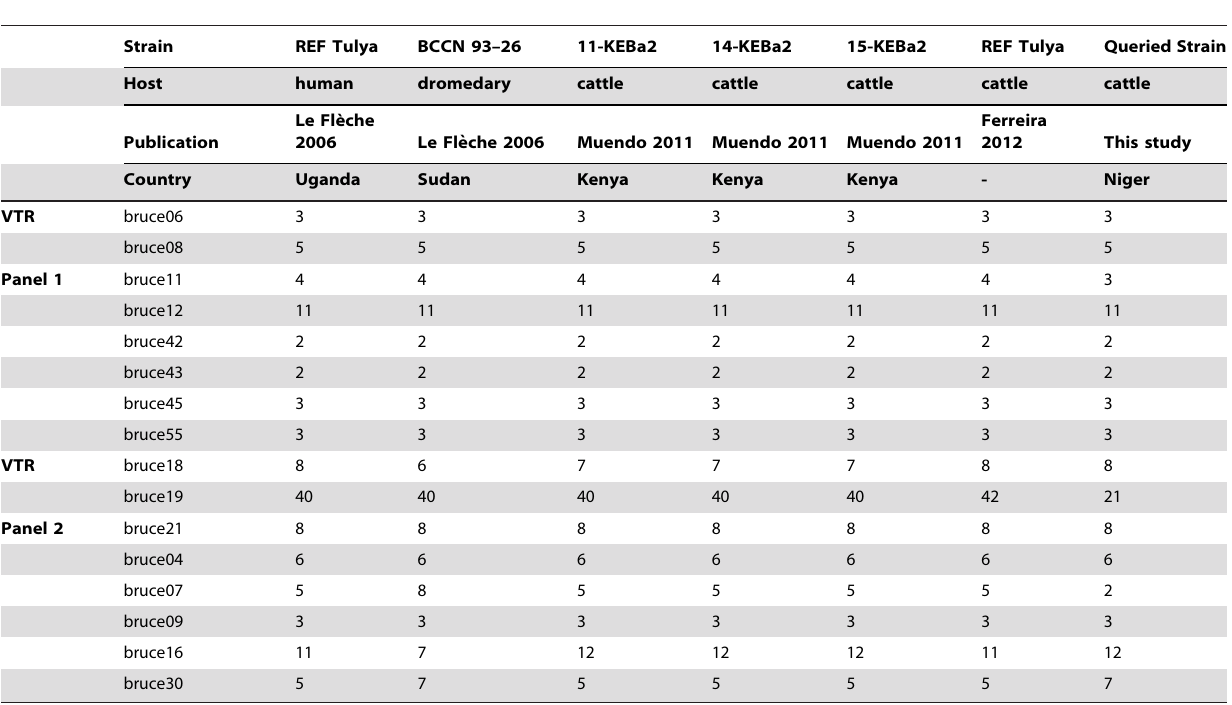
Table 8. The Multiple Loci Variable Number Tandem Repeats analysis (MLVA) profiles showing number of variable tandem repeats (VTR) for a B. abortus biovar 3 isolate from Niger (Queried Strain) and its closest MLVA neighbour